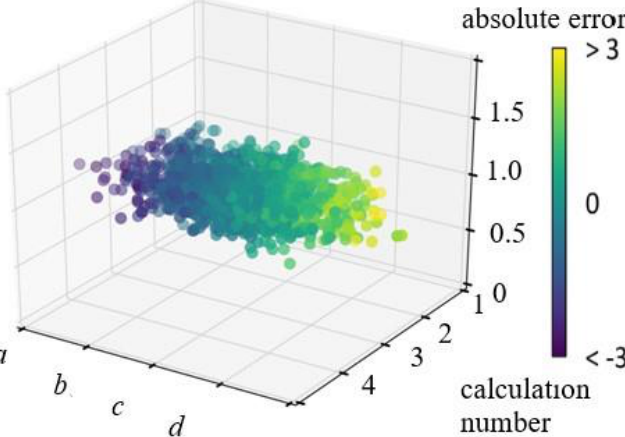
Figure 16. Calculation errors during mathematical modeling: a—ignoring the experimental data; b—taking into account the experimental data; c—taking into account the experimental data and the mathematical approaches; d—taking into account the experimental data but ignoring the mathe- matical approaches, where the absolute error (dimensionless unit), calculation number (dimen- sionless unit).